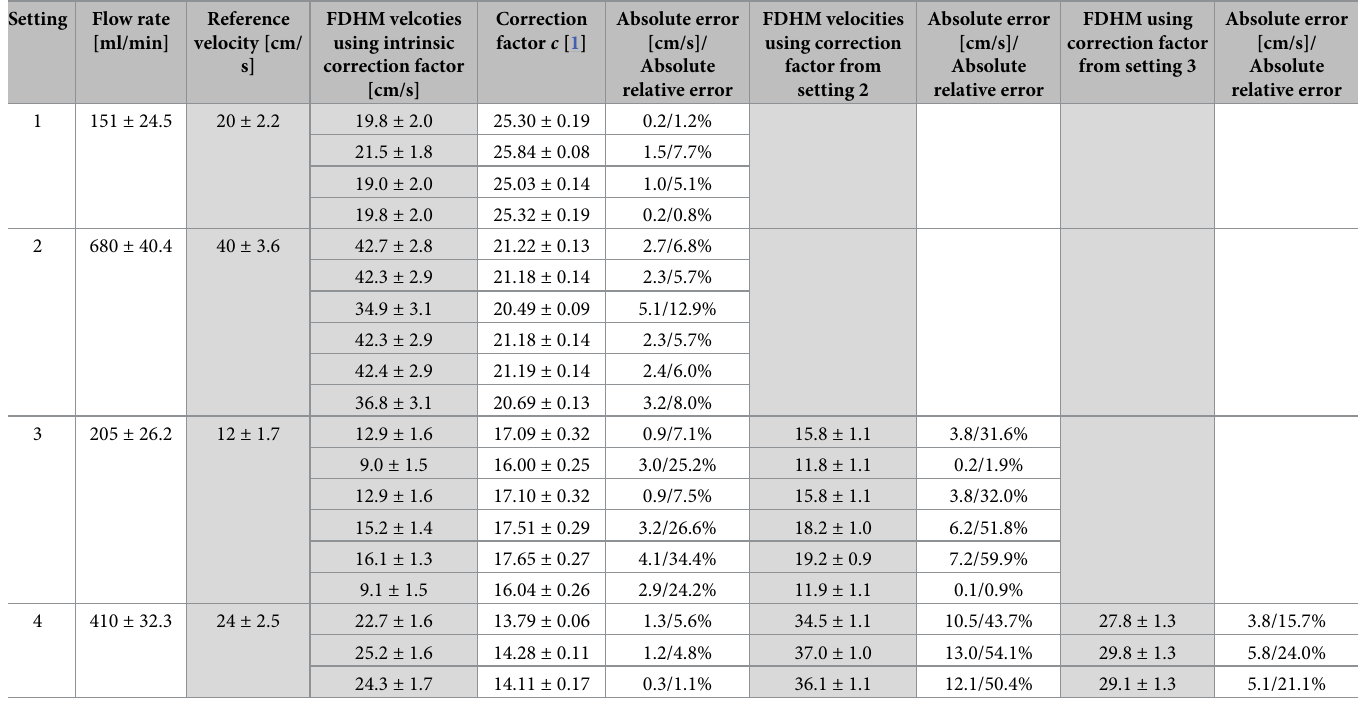
Table 3. MPI-calculated velocities in stenotic phantoms. Setting Flow rate